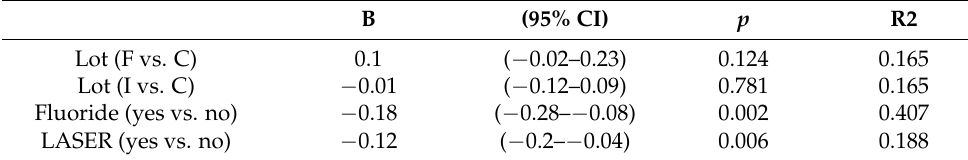
Table 5. Robust univariate submodels’ generation: